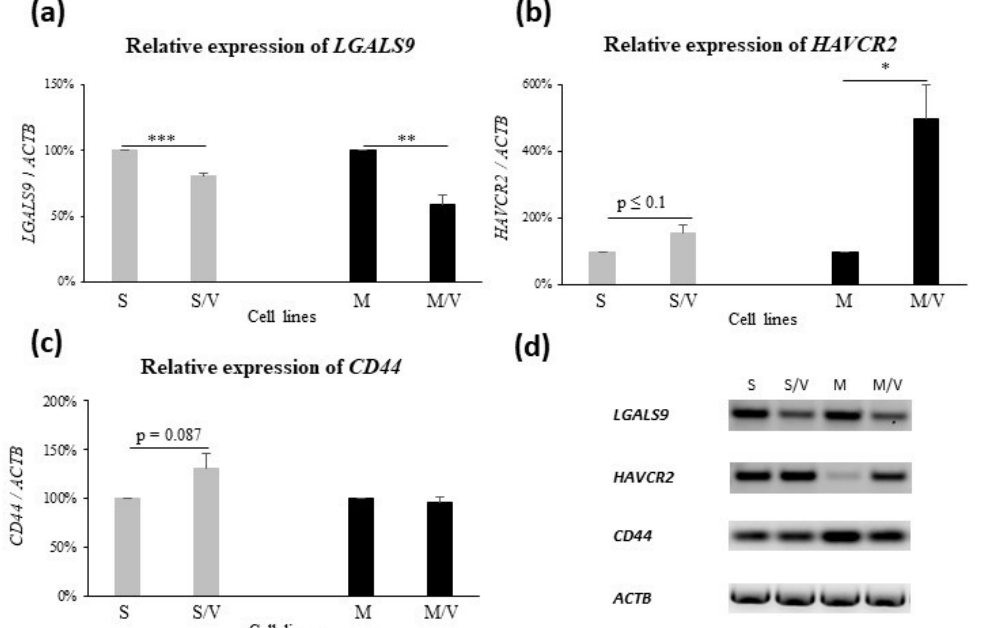
Figure 2. Expression of LGALS9 ( a ) and HAVCR2 ( b ) by qRT-PCR and CD44 detection by RT-PCR ( c ); ( d )—representative agarose gel of PCR products for all analyzed genes. Data from qRT-PCR represent the mean ± SEM of 4 independent experiments in which all samples were measured at least in duplicate. Data from RT-PCR represent the mean ± SEM of 4 independent experiments. Observed alterations in expression in resistant cell lines in comparison with their sensitive counterparts were statistically significant: * p ≤ 0.05; ** p ≤ 0.01; *** p ≤ 0.001. S—SKM-1; S/V—SKM-1/VCR; M—MOLM-13; M/V—MOLM-13/VCR.